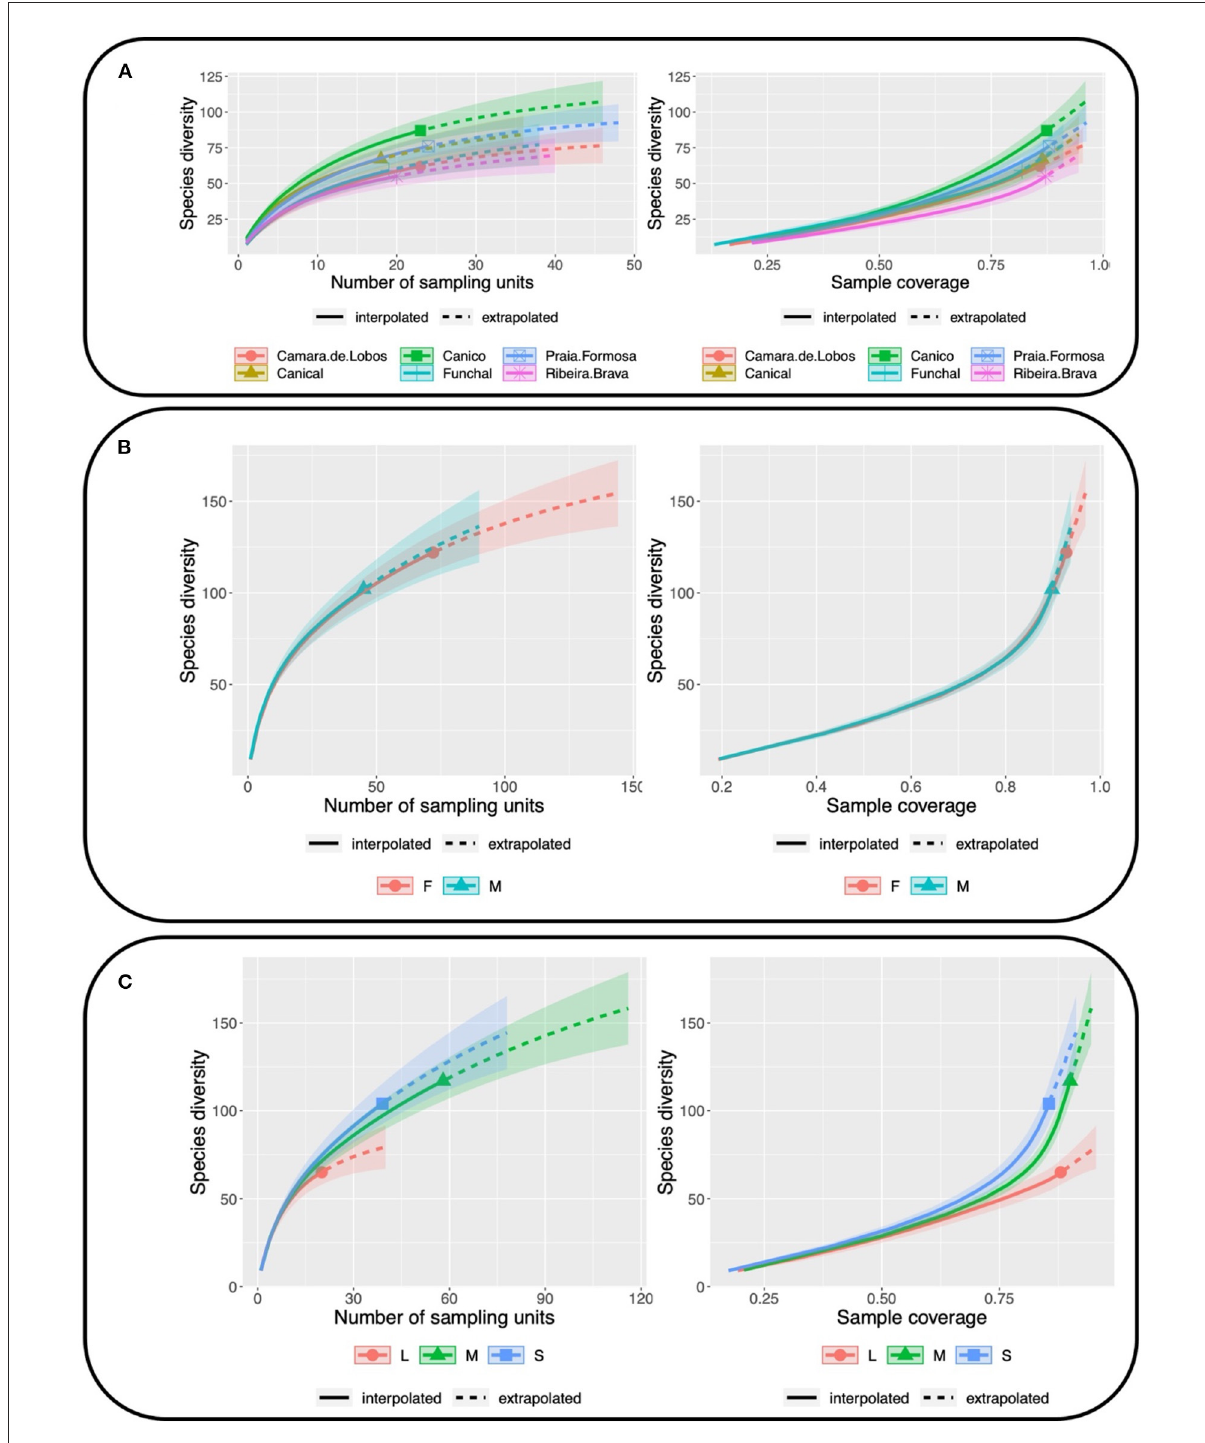
FIGURE2 Diet rarefaction/extrapolation curves for (A) Populations, (B) sex (M, male; F, female) and (C) size (S, small; M, medium; L, large), obtained according to the number of sampling units (left) and sample coverage (right) using iNEXT package from R.